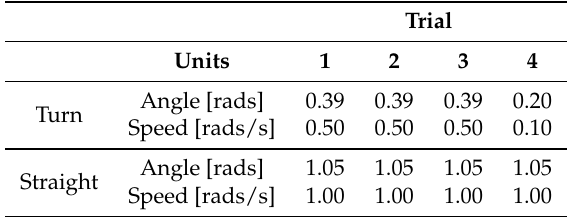
Table 12. Configuration parameters for the indoor circuit